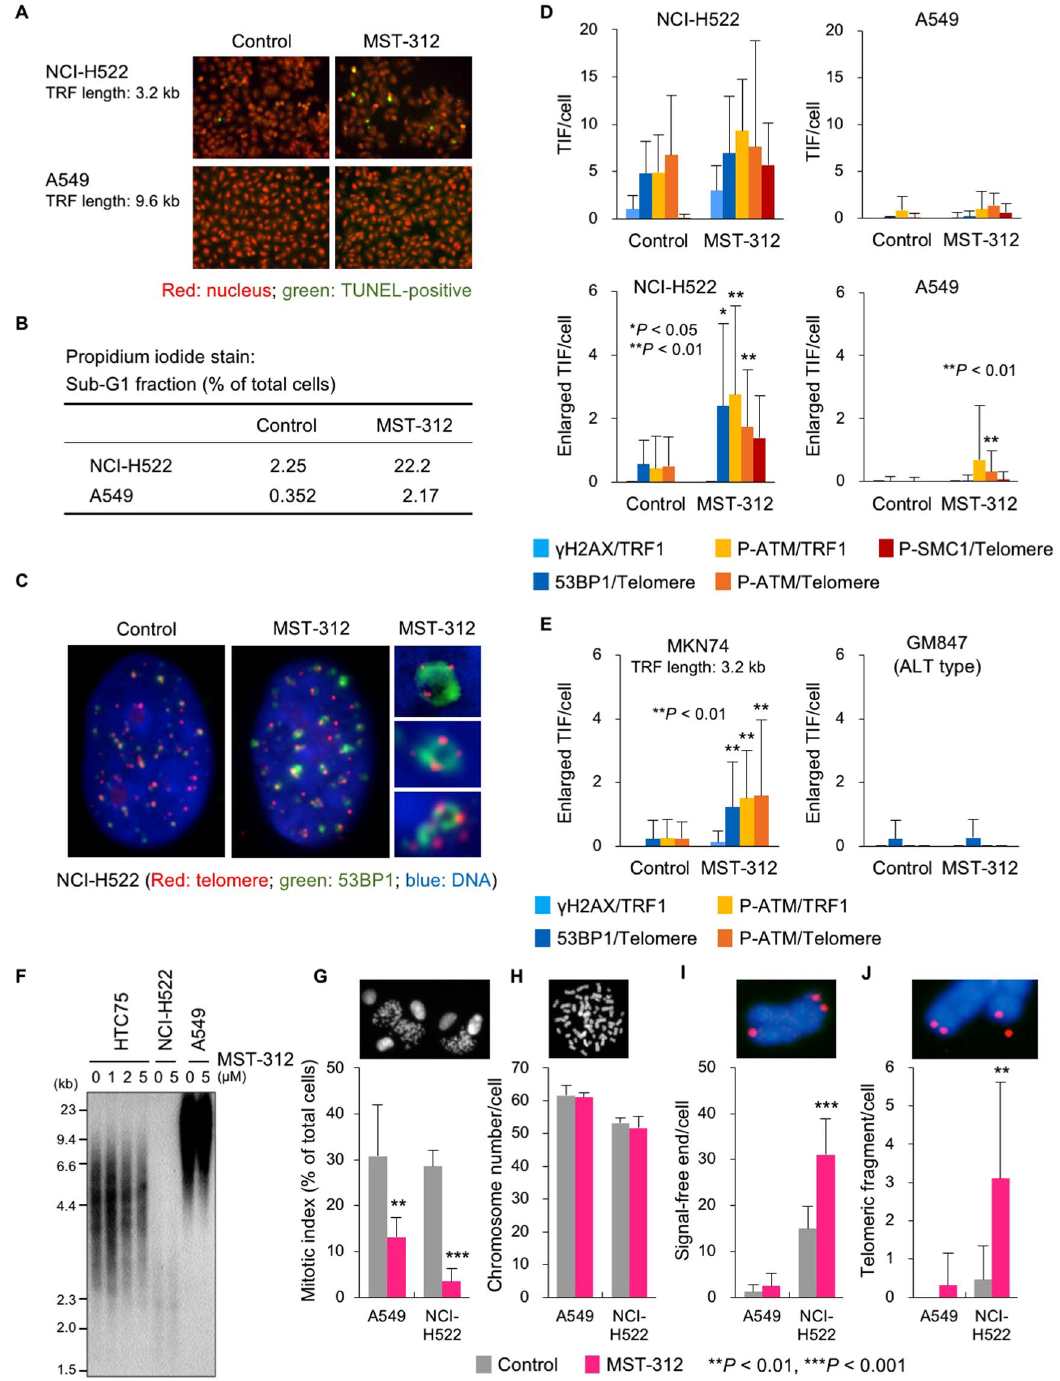
Figure 2. Telomere dysfunction induced by MST-312. ( A ) TUNEL assay of MST-312-treated cells. Human lung cancer NCI-H522 [mean telomeric restriction fragment (TRF) length = 3.2 kb] and A549 (mean TRF length = 9.6 kb) cells were treated with 5 μ M MST-312 for 48 h and then subjected to TUNEL assay for detection of apoptotic cells ( green ). ( B ) Quantification of apoptotic cells. Cells were treated as in ( A ) and then stained with propidium iodide; the apoptotic sub-G1 fraction was quantitated by flow cytometry. ( C ) Immuno-FISH analysis of NCI-H522 cells treated with 5 μ M MST-312 for 48 h. Red : telomere DNA; green : 53BP1; blue : DAPI. Right panels are magnified views of enlarged telomere dysfunction-induced foci (TIF). ( D , E ) Quantitation of TIF. Cells were treated as in ( A ), and telomeres and the indicated proteins were detected by FISH and immunofluorescence staining, respectively. Because the cells with short telomeres gave high background levels of TIF even without MST-312 treatment ( D , upper left ), enlarged TIF were quantitated as a hallmark of the MST-312-induced telomeric DNA damage response. Error bar indicates standard deviation. Asterisk indicates statistical significance in the difference between control and MST-312-treated cells (unpaired two-tailed